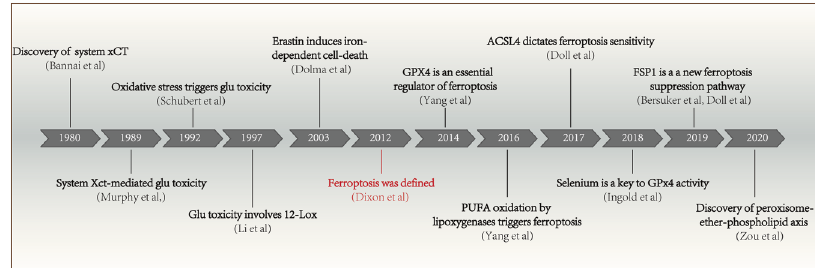
Fig. 1 Timeline diagram depicting essential discoveries in the fi eld of ferroptosis research. The discovery of ferroptosis starts with identi fi cation of system xCT, which was published in 1980. However, the term ‘ ferroptosis' was only named in